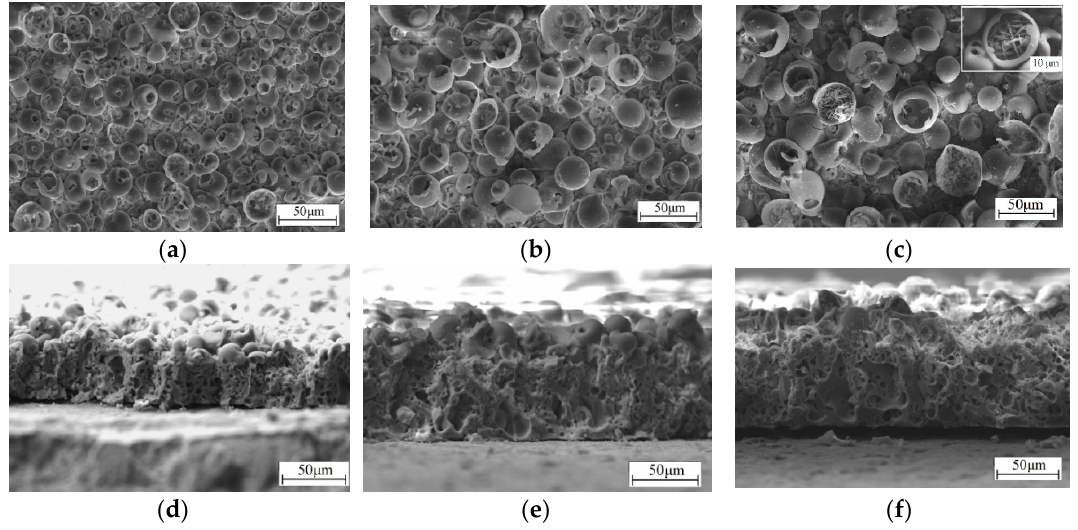
Figure 4. SEM images of the surface ( a – c ) and cross section ( d – f ) of CaP coatings obtained at different process voltages ( V ): CaP1 200 ( a , d ), CaP2 250 ( b , e ), CaP3 300 ( c , f ) .